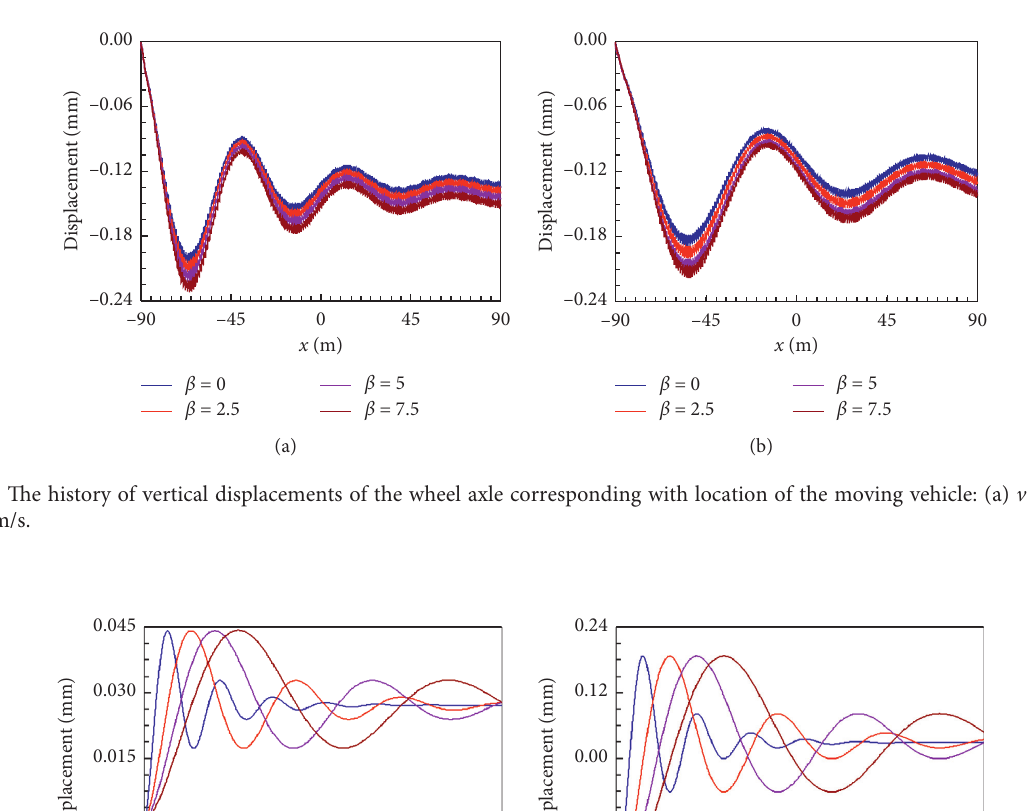
� 1 × 10 7 N and (b) k � 1 × 10 8 s s